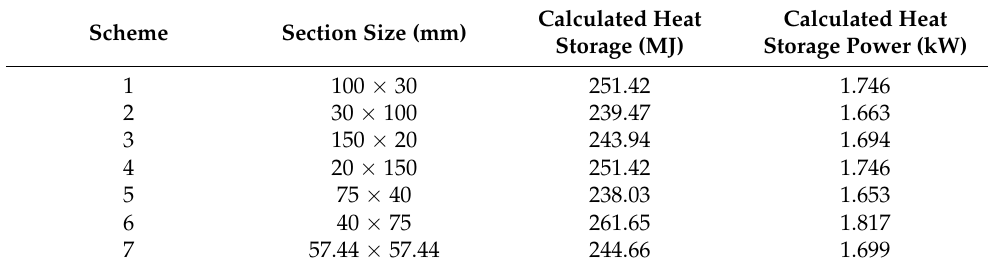
Table 8. Calculated heat storage and calculated heat storage power corresponding to geometric sizes of different phase change heat storage